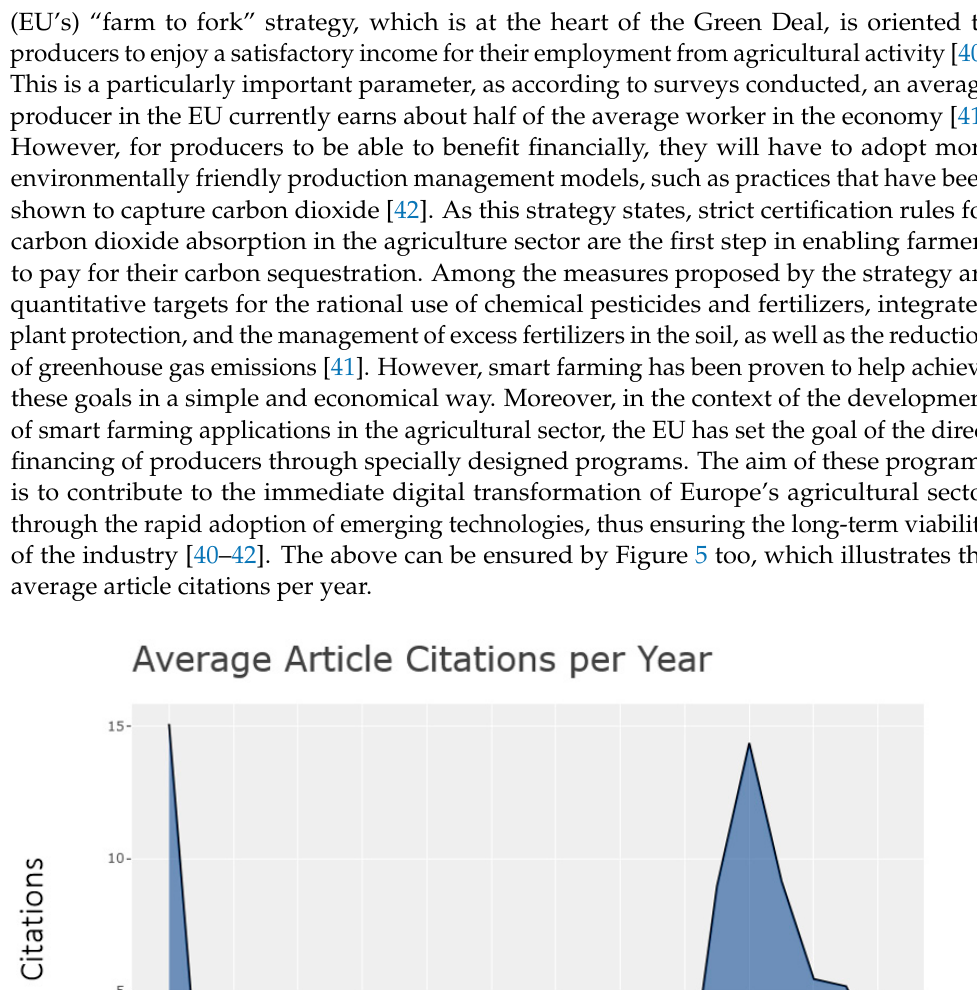
Table 1. Most relevant resources in the field of smart and precision farming.